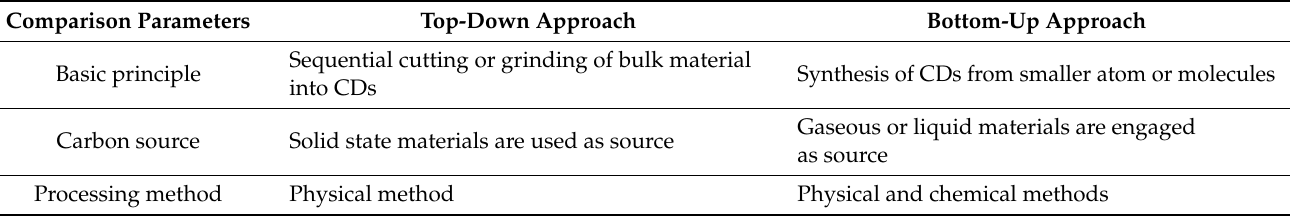
Table 1. Difference between Top-down and Bottom-up approaches in CDs synthesis. Comparison Parameters Basic